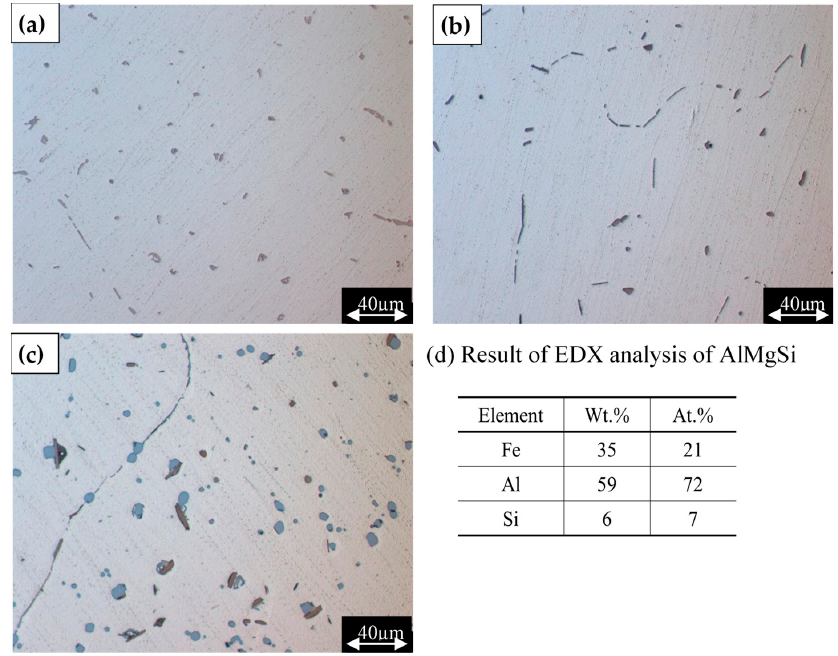
Figure 2. Optical micrographs of as-quenched Al-Mg2Si alloys: ( a ) Al-1.1Mg2Si; ( b ) Al-1.9Mg2Si; ( c ) Al-3.5Mg2Si; and ( d ) result of EDX analysis of AlFeSi phase (gray phase in (c)).